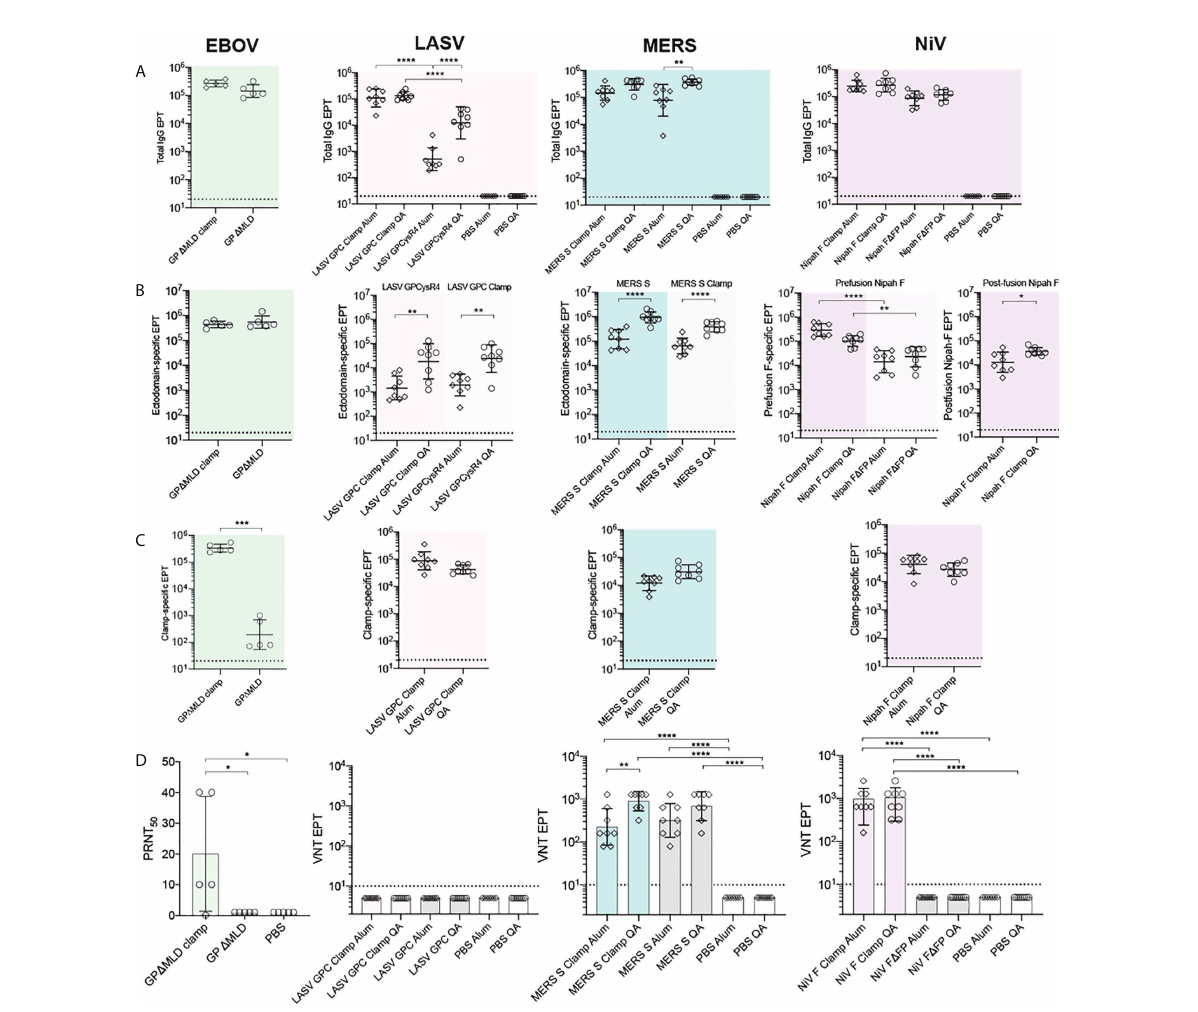
FIGURE 3 Immunogenicity and neutralization of virus. Serum reactivity in BALB/c immunised mice was assayed by ELISA and is presented as end-point titres (EPTs). (A) Sera groups were assayed against their cognate antigen (Total IgG), (B) an ectodomain only antigen (Ectodomain-speci fi c) and (C) an in fl uenza virus hemagglutinin-clamp antigen (Clamp-speci fi c) (n = 5 for EBOV groups; n = 8 for LASV, MERS-CoV and NiV groups). (D) Neutralisation against live virus. Serum neutralization of EBOV was determined as the serum dilution factor required to neutralise 50% of the virus (PRNT 50 ). For LASV, MERS-CoV and NiV, virus neutralisation titre (VNT) was determined as the inverse serum concentration at which CPE was not observed. P values were determined by one-way ANOVA using Tukey ’ s multiple comparison test. Statistical signi fi cance is indicated as: p < 0.0001 (****), p < 0.001 (***), p < 0.01 (**), and p < 0.05 (*). Error bars show